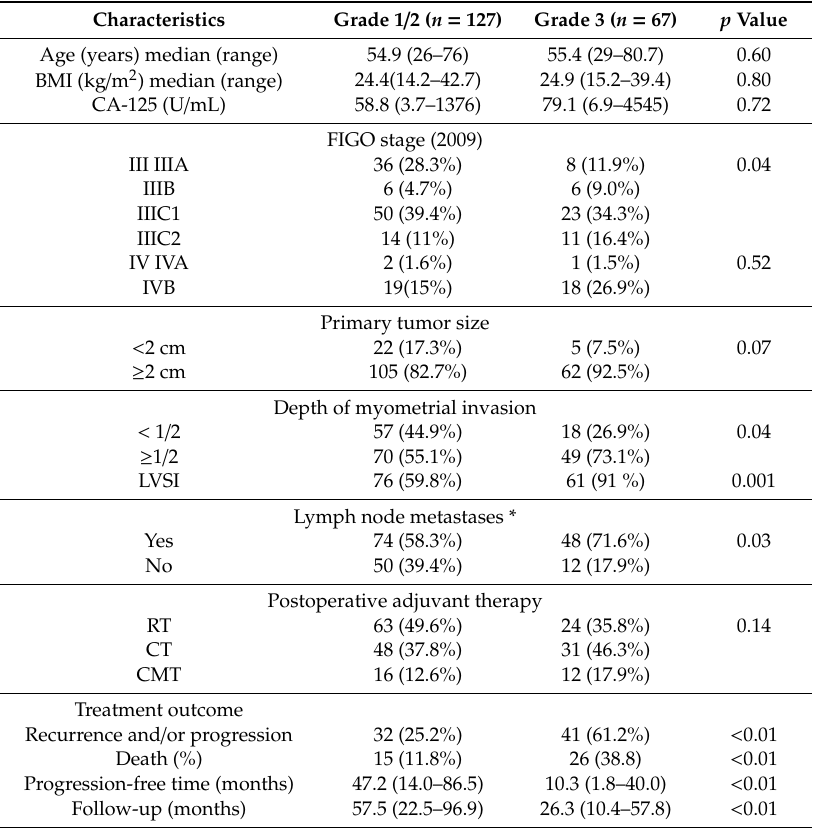
Table 2. The clinico-pathologic characteristics of grade 1 / 2 and grade 3 endometrioid endometrial carcinoma in 194 advanced-stage patients.